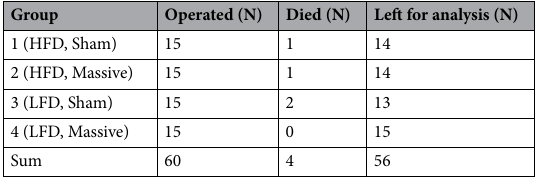
Group Operated (N) Died (N) Left for analysis